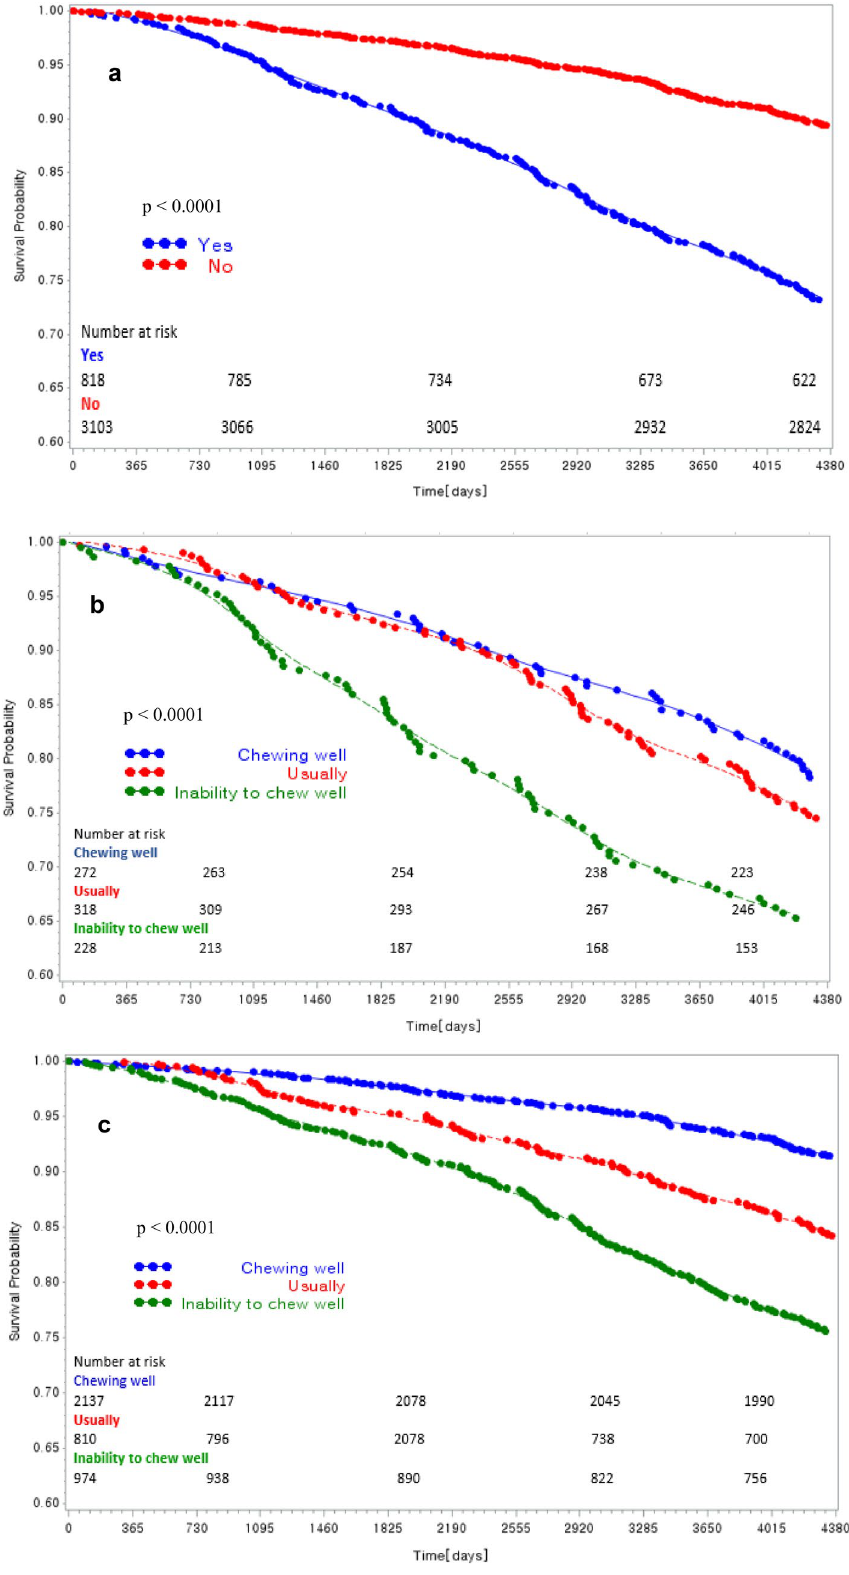
Figure 2. Kaplan–Meier plot showing the mortality, by the denture use and chewing abilities, in the regular exercise group. The Kaplan–Meier curve is an estimator of the survival function. The Kaplan–Meier curve is the visual representation of this function and shows the probability of an event at a given time interval. The p value is for the log-rank test. ( a ) The cumulative mortality based on the denture use ( b ) The cumulative mortality based on the chewing ability of denture users ( c ) The cumulative mortality rate based on the chewing ability of denture